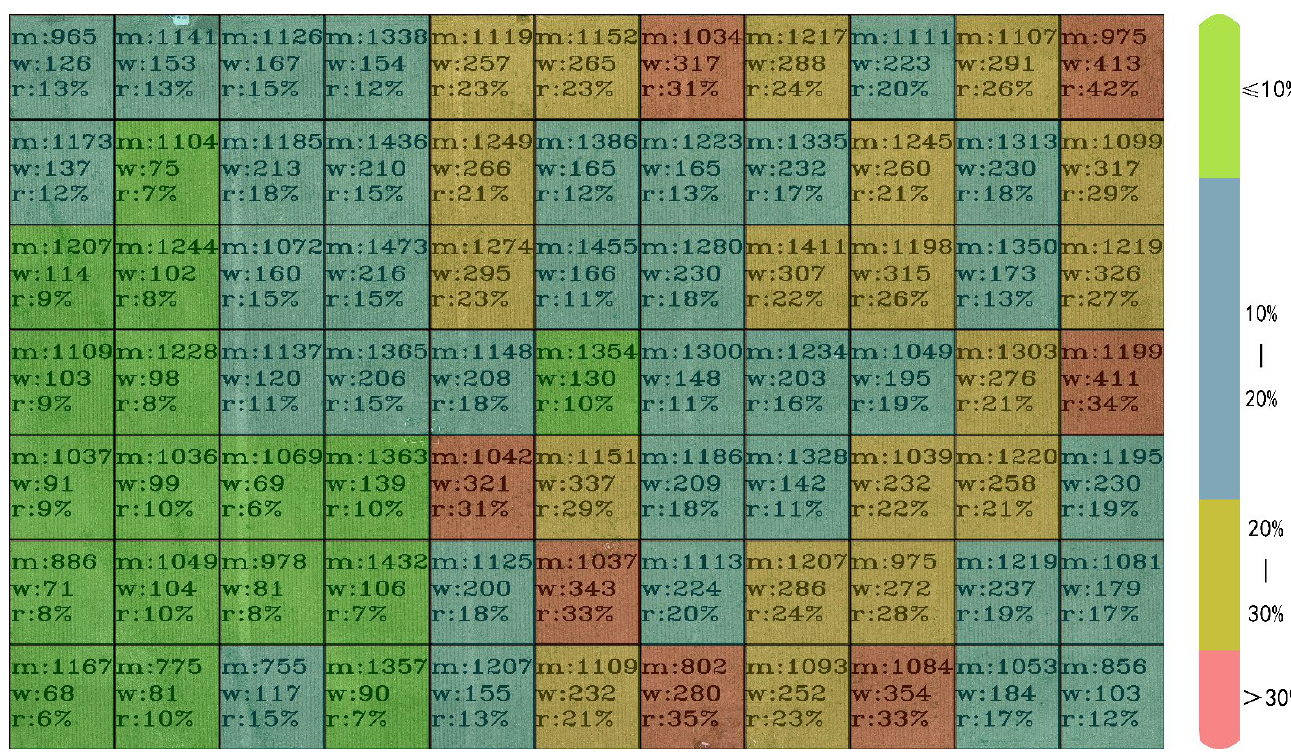
Figure 12. The image is divided into small areas for data analysis.